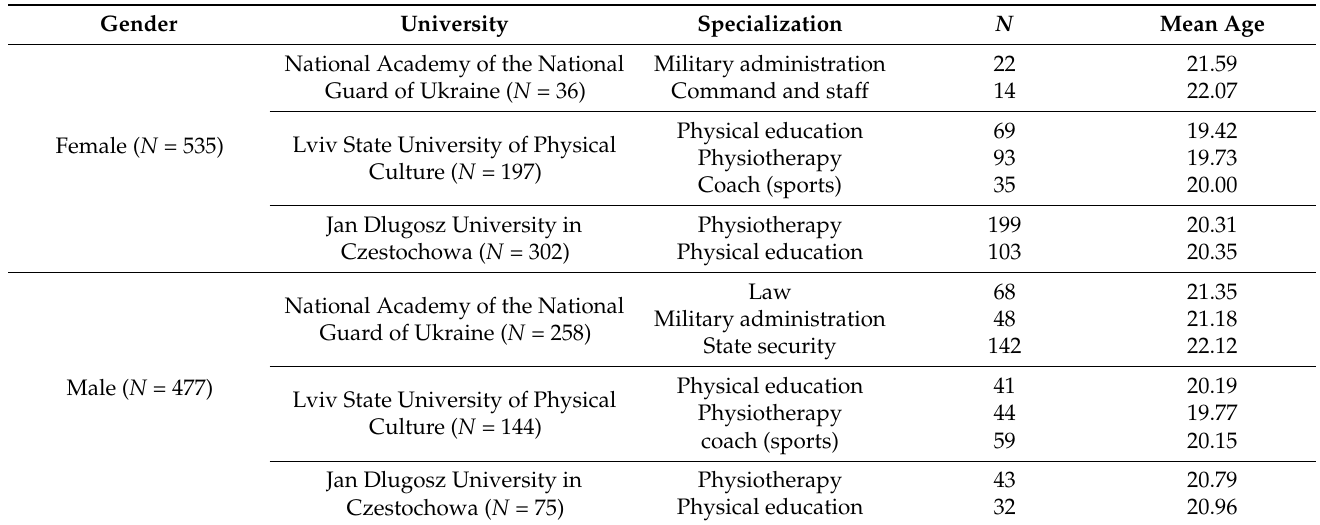
Table 1. Characteristics of the participants by gender, university and specialization (N = 1012).